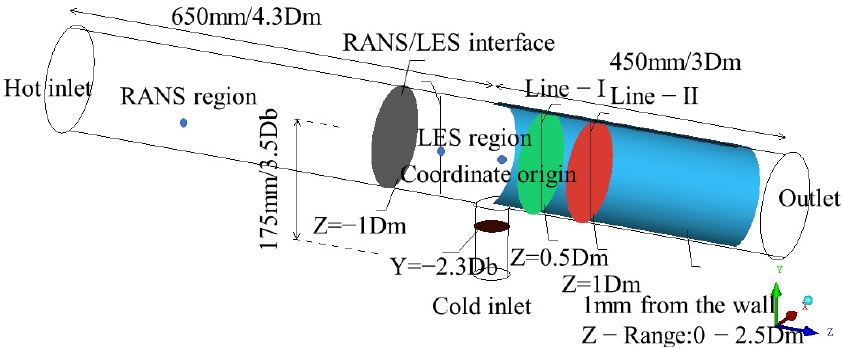
Figure 1. Schematic diagram of the computational domain.